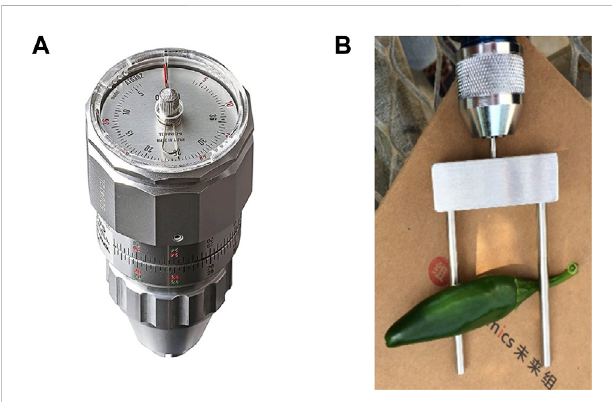
FIGURE 1 TorqueWatch (A) withcustomfork (B) tomeasurebendingforceof pepper fruit. This instrument measures the maximum bending force at breaking of pedicel from fruit when twisting.